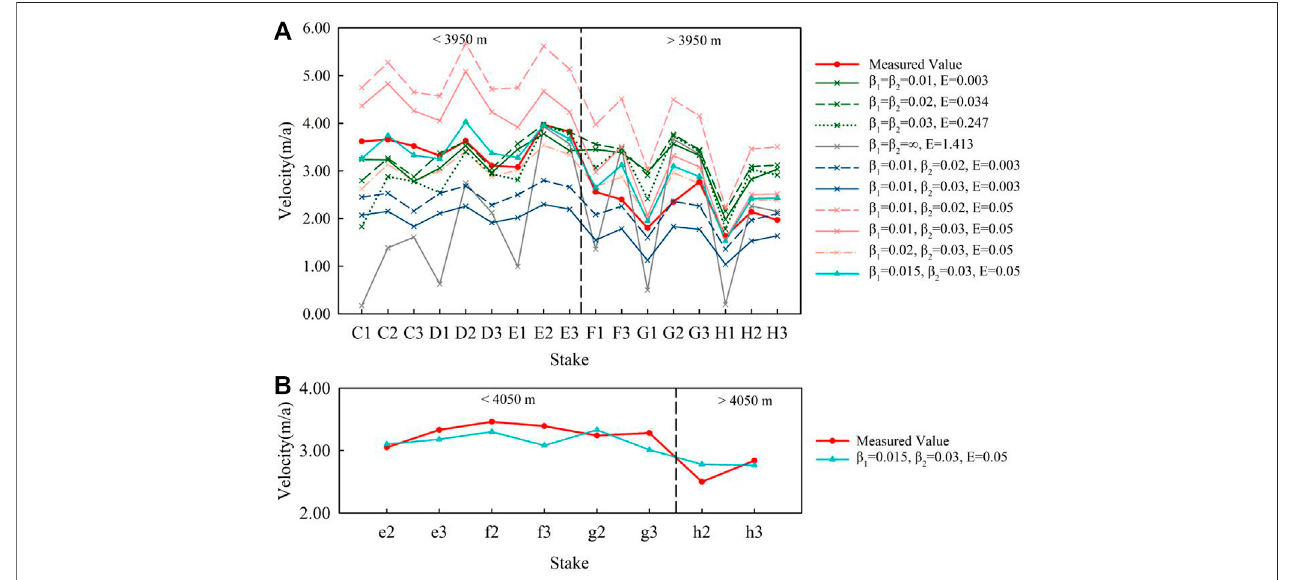
FIGURE7| SimulatedresultsoftheEBandtheWBfortheslidingstates. (A) Measuredvelocities,fullsliding,nosliding,andpartialslidingattheglacierbaseresults of the EB, and the black dashed line denotes the elevation of 3,950 m; (B) Measured velocities, partial sliding at the glacier base simulation results of the WB, and the black dashed line denotes the elevation of 4,050 m.